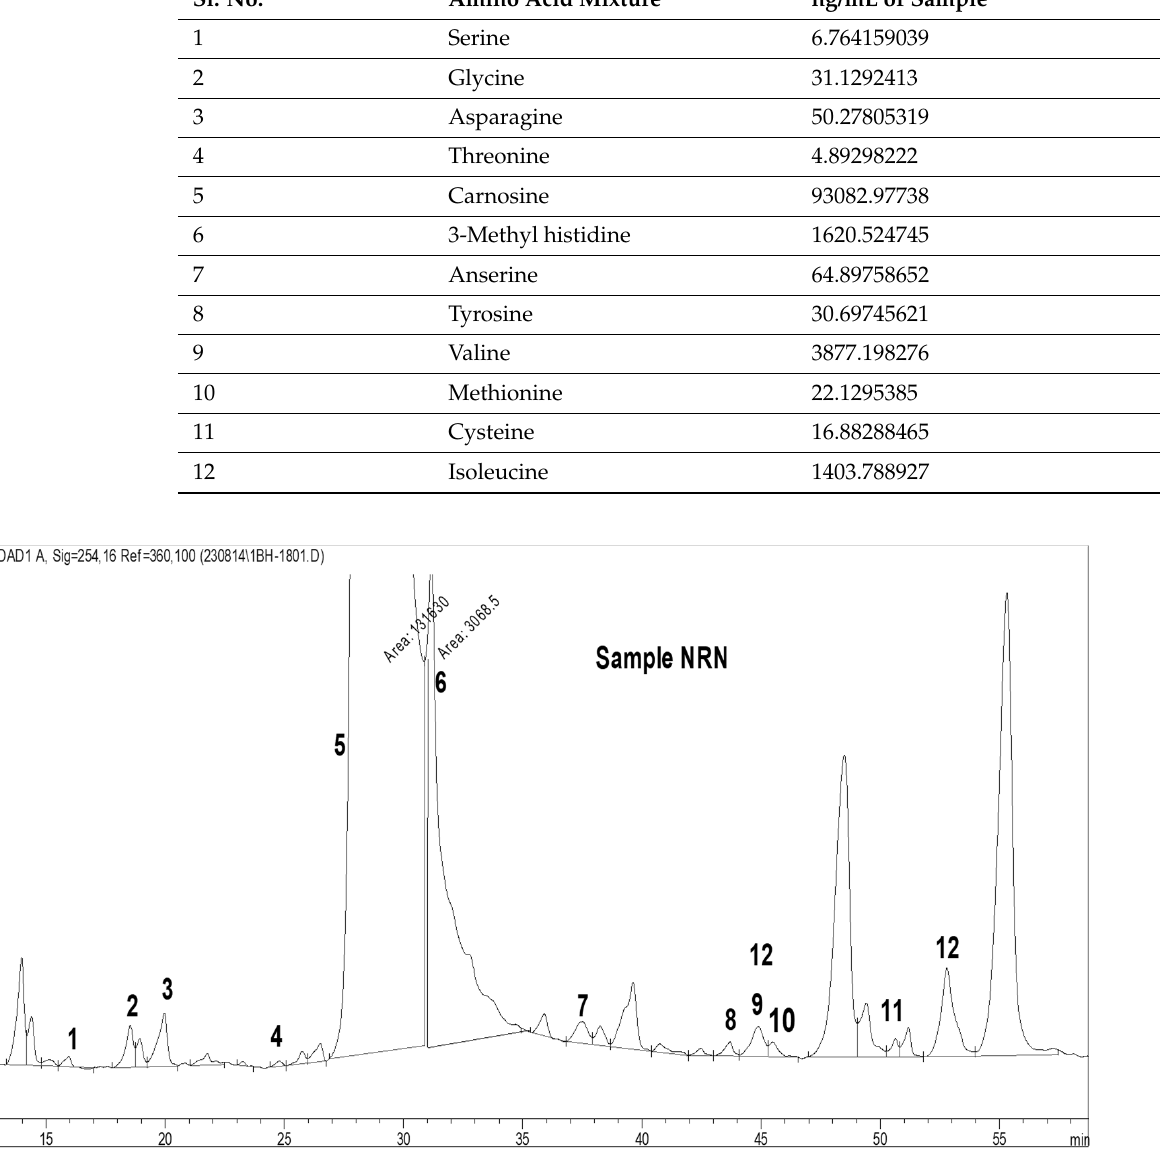
Figure 6. TAA content in the R. palustris NR MPPR phototrophic bacteria determined by HPLC. Table 3. TAA content in R. palustris NR MPPR (HPLC). Sl. No.